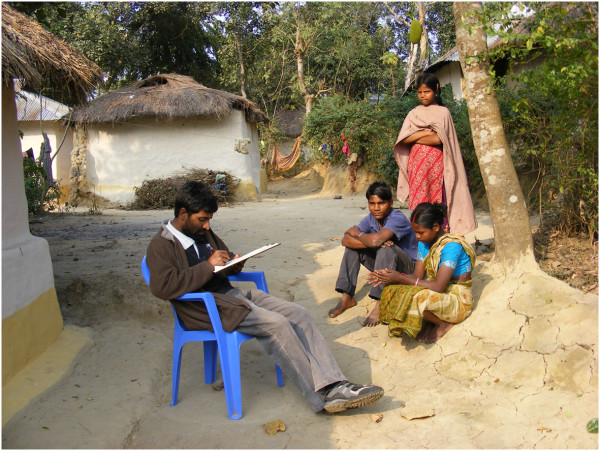
Household interviews in BTRI.